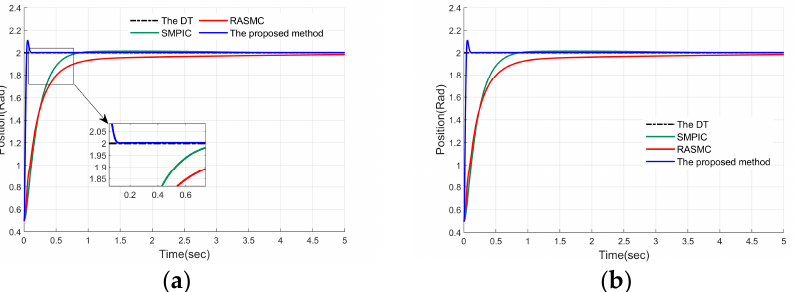
Figure 19. Comparison of controller response speed under step signals ( a ) the response speed of θ 1 and ( b ) the response speed of θ 2